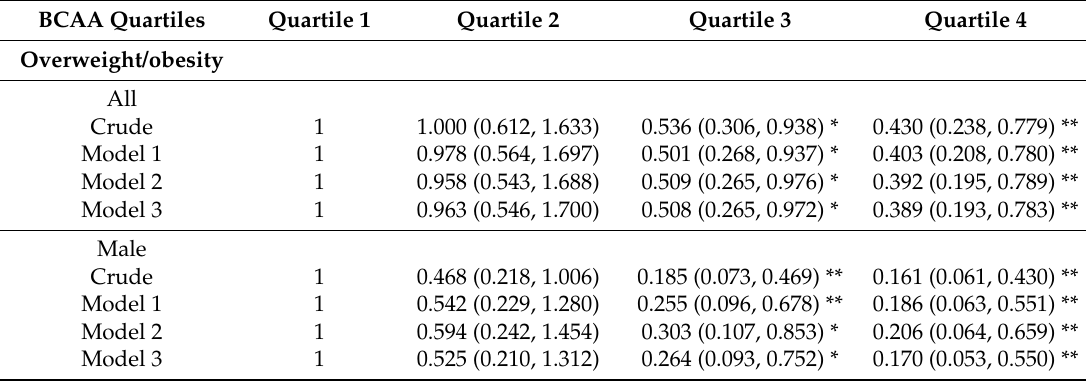
Table 3. Multivariable-adjusted OR and 95% CI of overweight/obesity and abdominal obesity by quartile of BCAAs